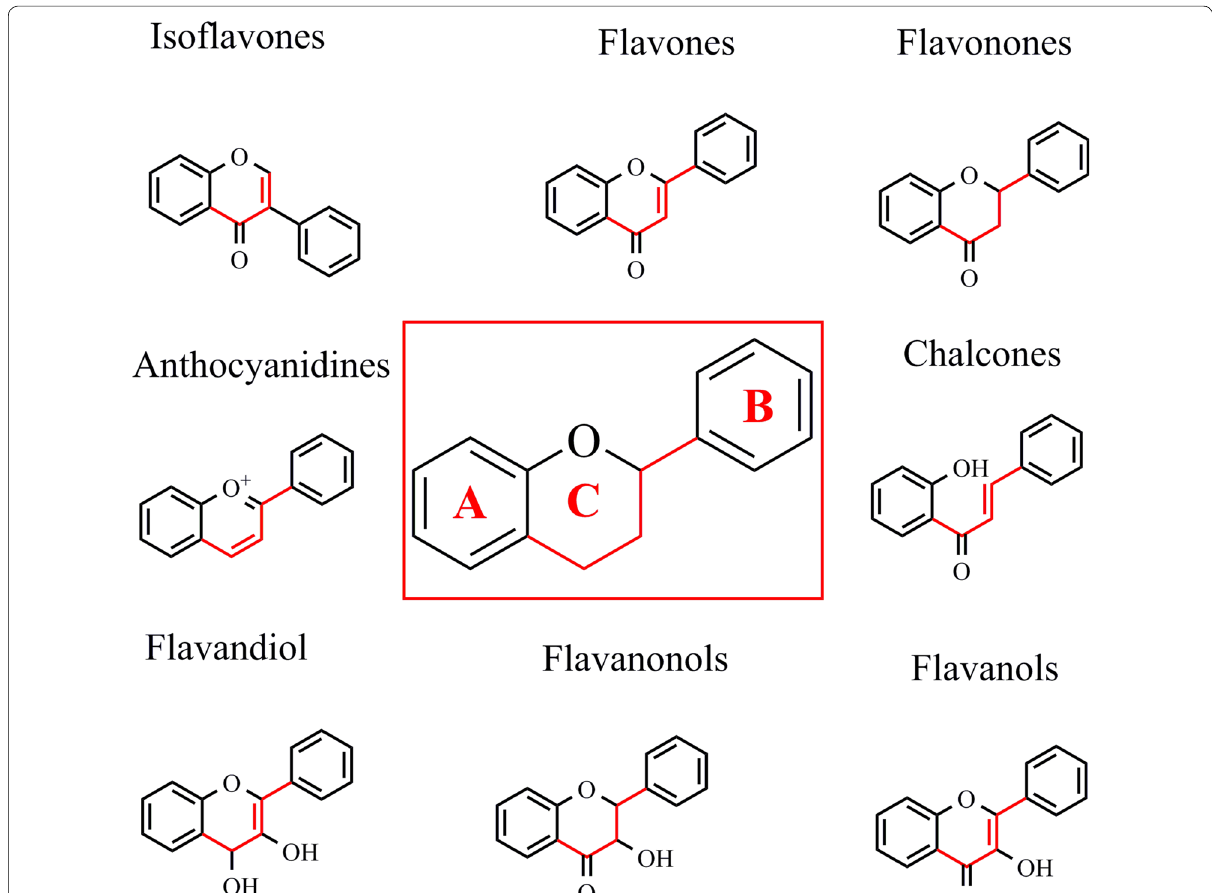
Fig. 1 Subfamilies of flavonoids. Flavonoids include the following subfamilies: flavones, flavanols, isoflavones, flavonols, flavanones, and flavanonols, which differ in their ring substituents and extent of